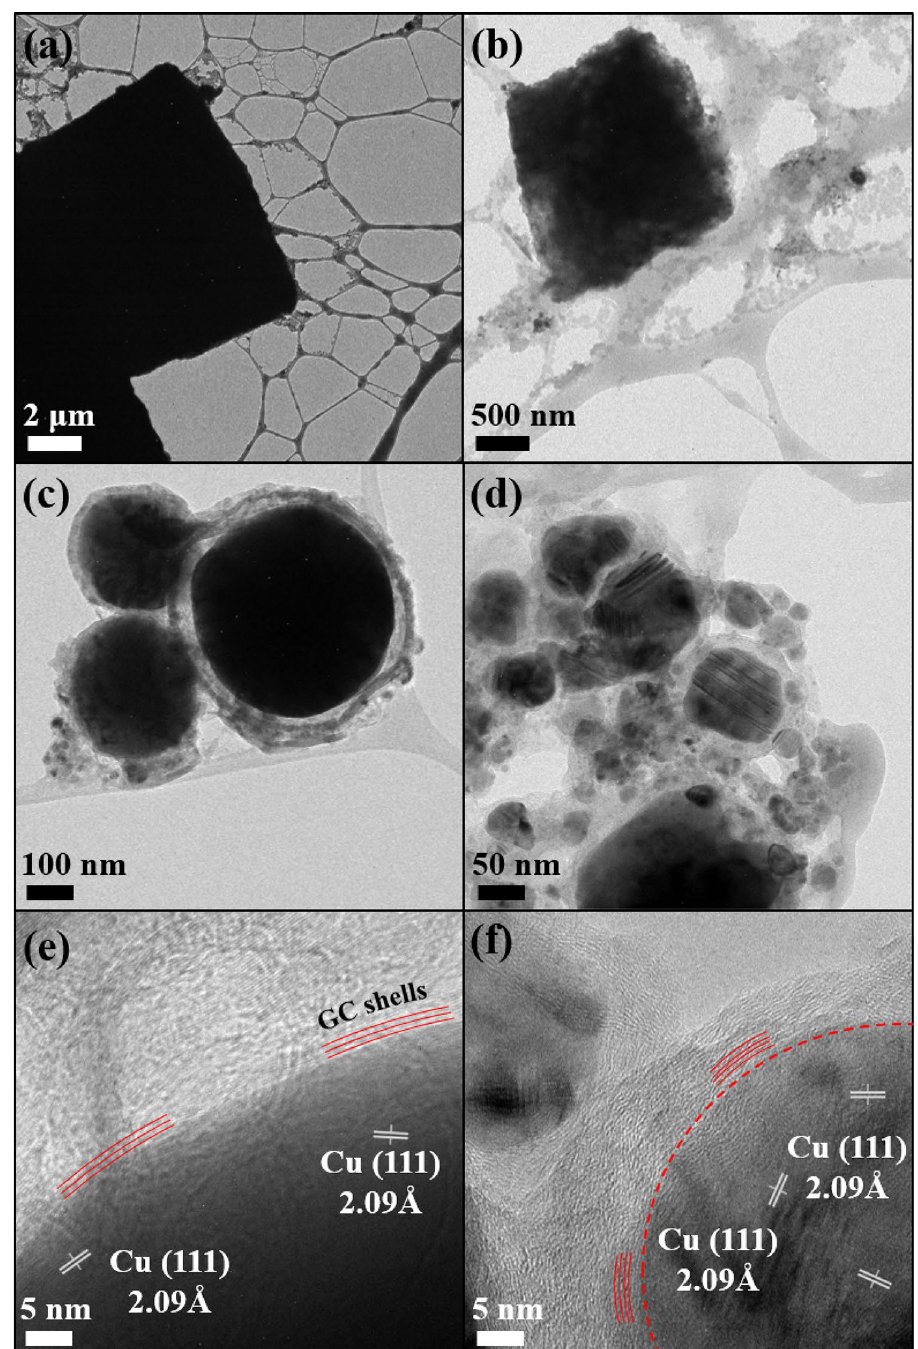
Figure 6. TEM images of ( a , b ) CuCN and ( c - f ) Cu@GC prepared by PLAL at 1064 nm